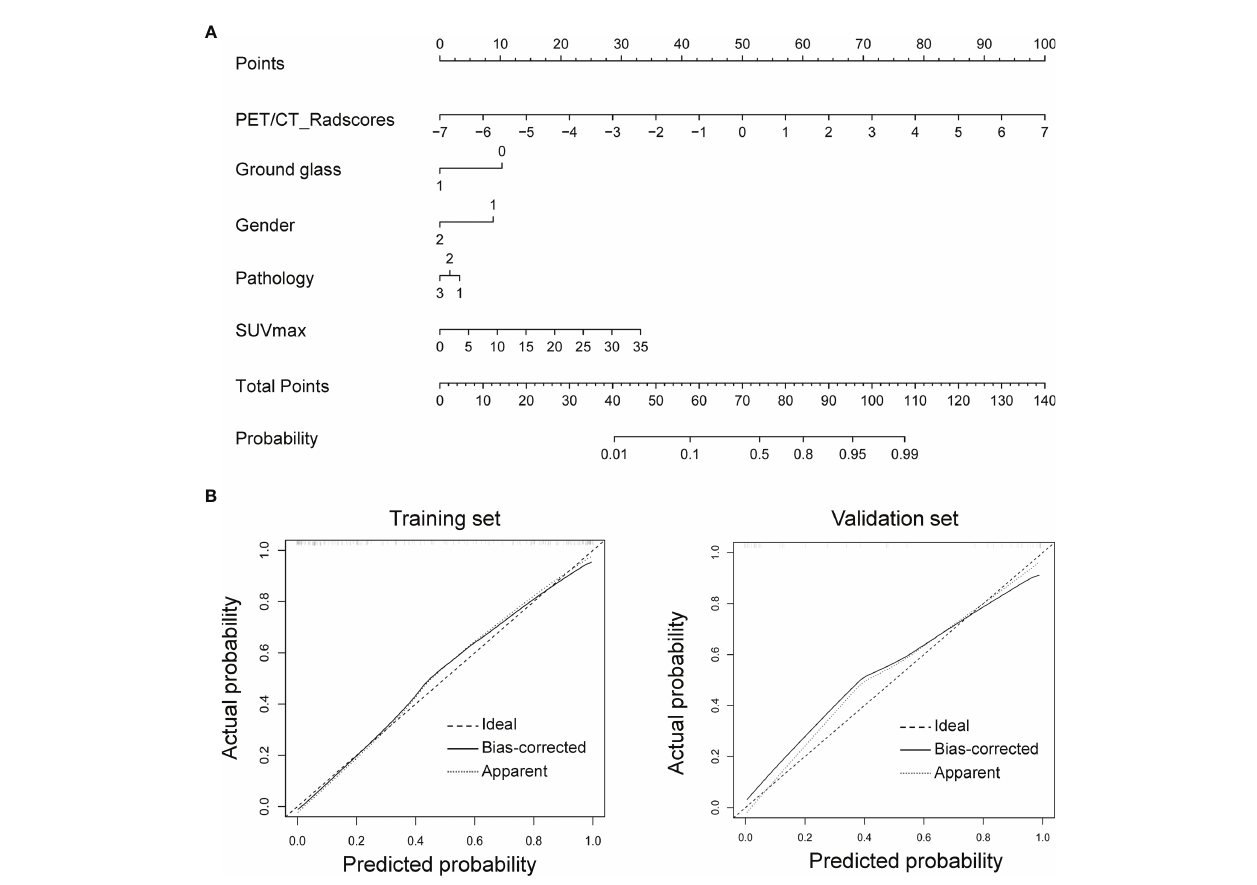
FIGURE 5 | Nomogram for CD8 expression status prediction. (A) Nomogram integrating clinical features with Rad-score. (B) The nomogram ’ s calibration was assessed using calibration curves, which was con fi rmed by Hosmer – Lemeshow test in the training (left) and validation sets